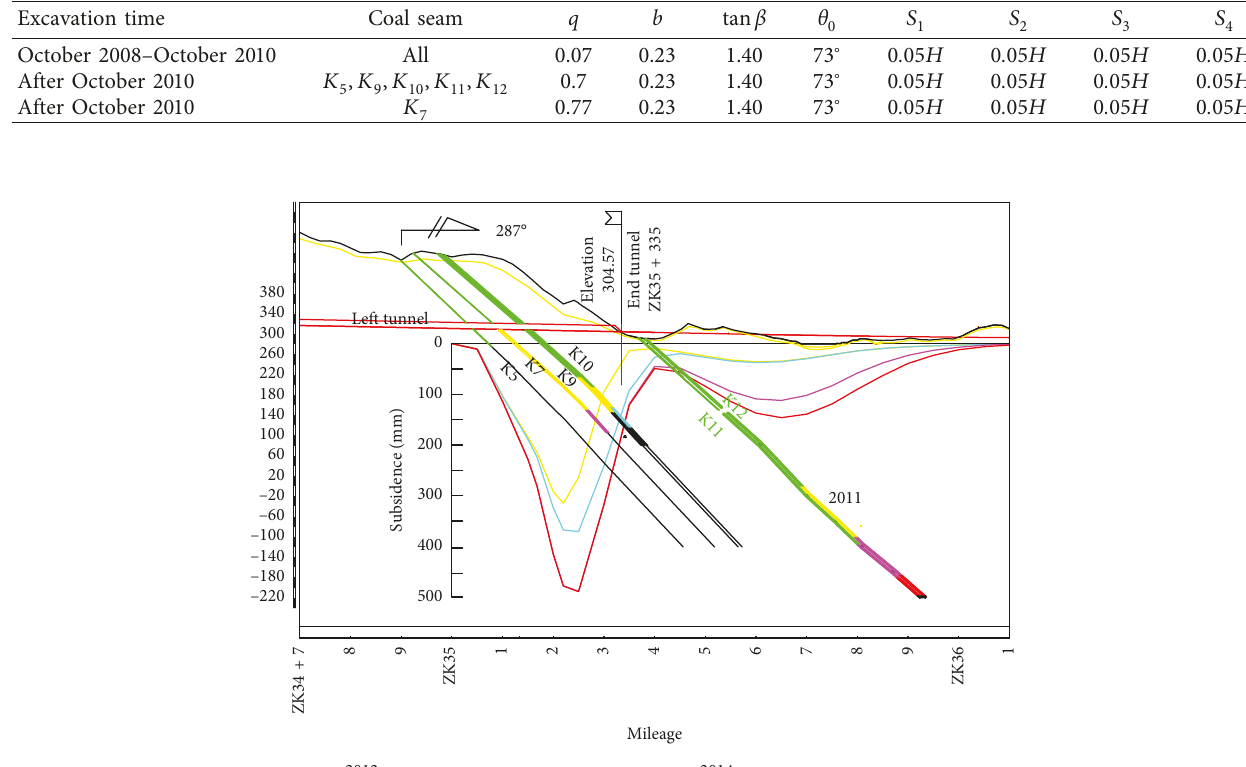
Table 2: PIM parameters used in